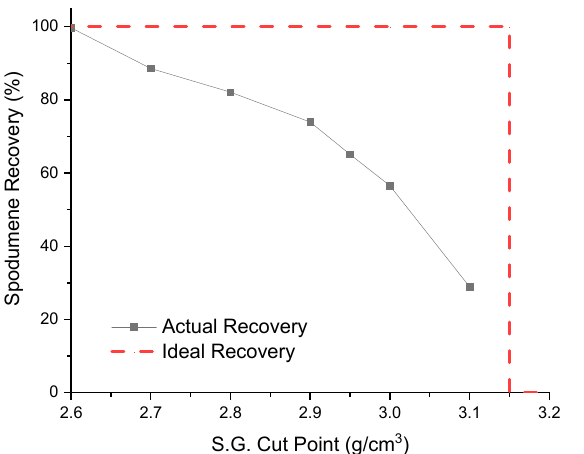
Figure 8. Ideal and actual spodumene separation as a function of specific gravity cut point in heavy liquid separation.